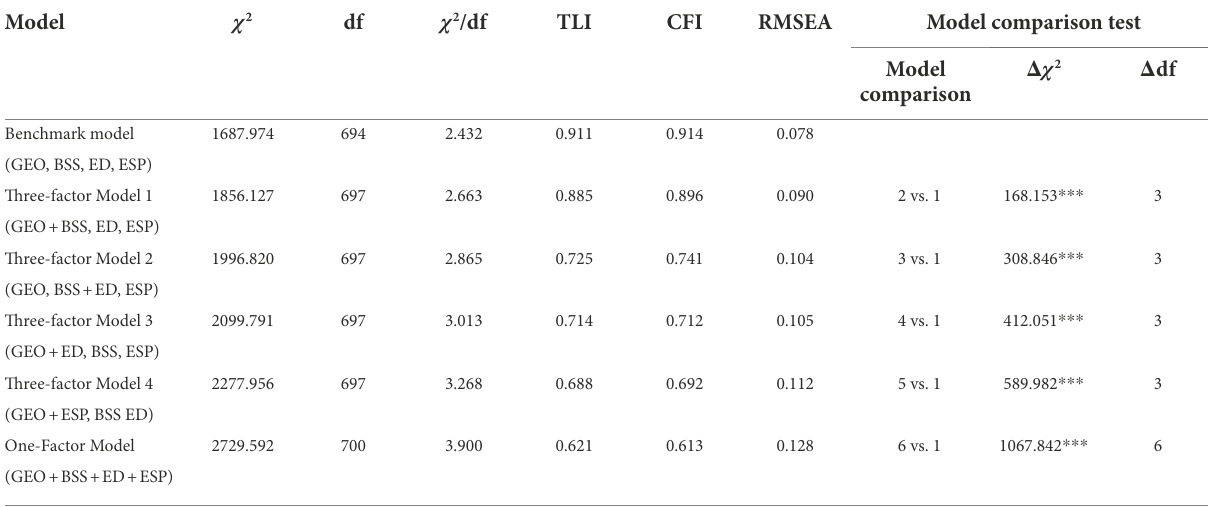
TABLE 3 Discriminant validity